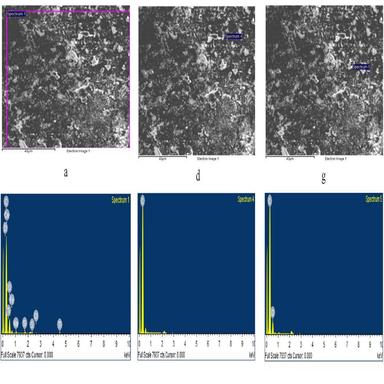
SEM and EDS surface images of PC-Ph composite specimen surfaces.